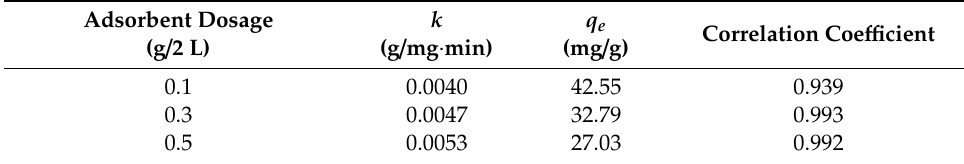
Table 3. Kinetic parameters for MB biosorption onto DM-BC at various DM-BC dosages based on the pseudo-second-order model a